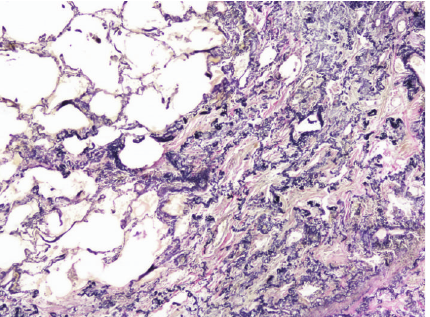
Figure 10: Case 2. Elastosis areas were sharply defined and showed an abrupt transition to normal tissue. Van Gieson